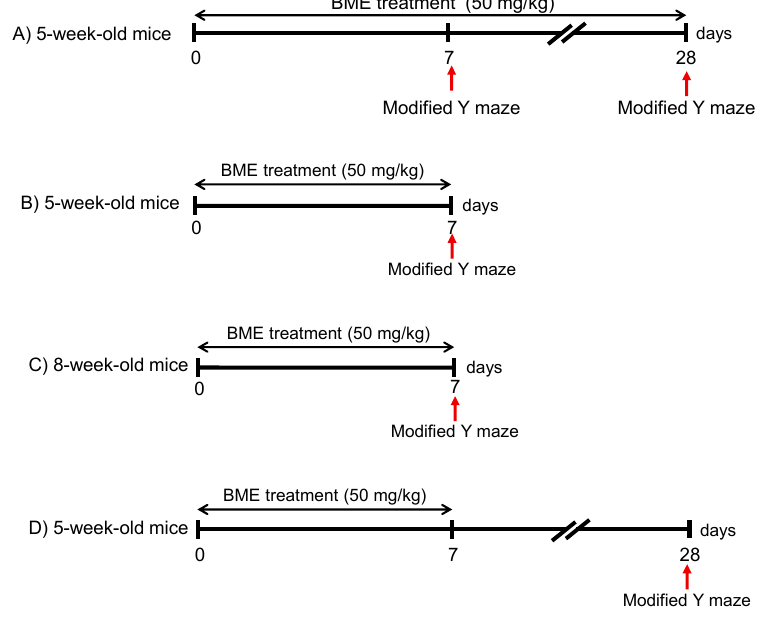
Figure 7. Experimental schedule to examine the effect of BME (50 mg/kg) on spatial working memory in adolescent (5-week-old) or adult (8-week-old) mice using the modified Y maze. ( A ):